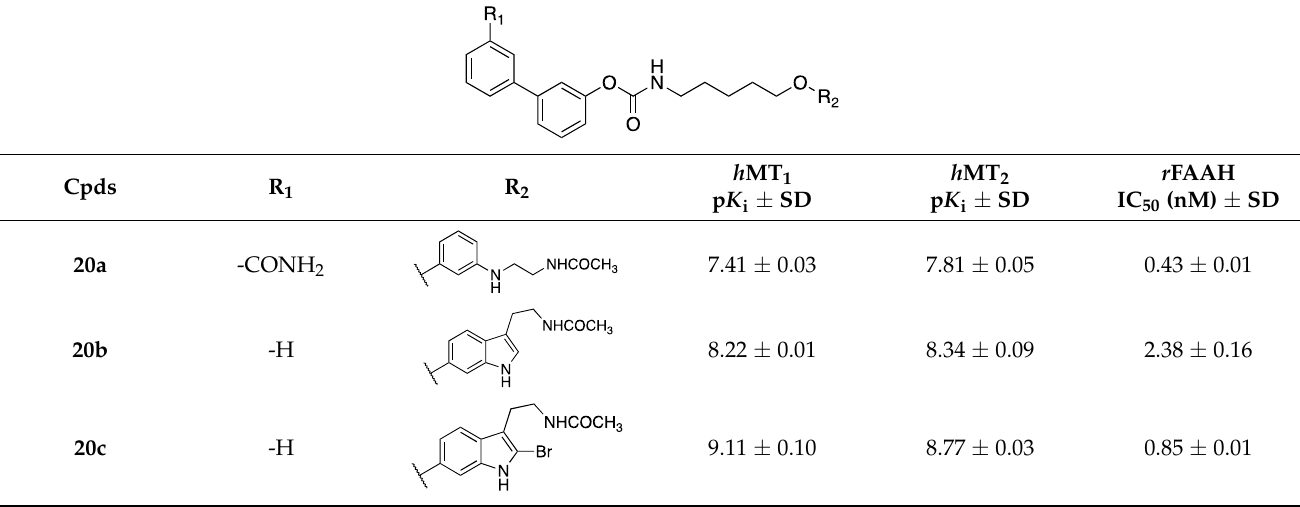
Table 11. Inhibitory activities of compounds 20a–c against h MT 1-2 receptors and r FAAH.